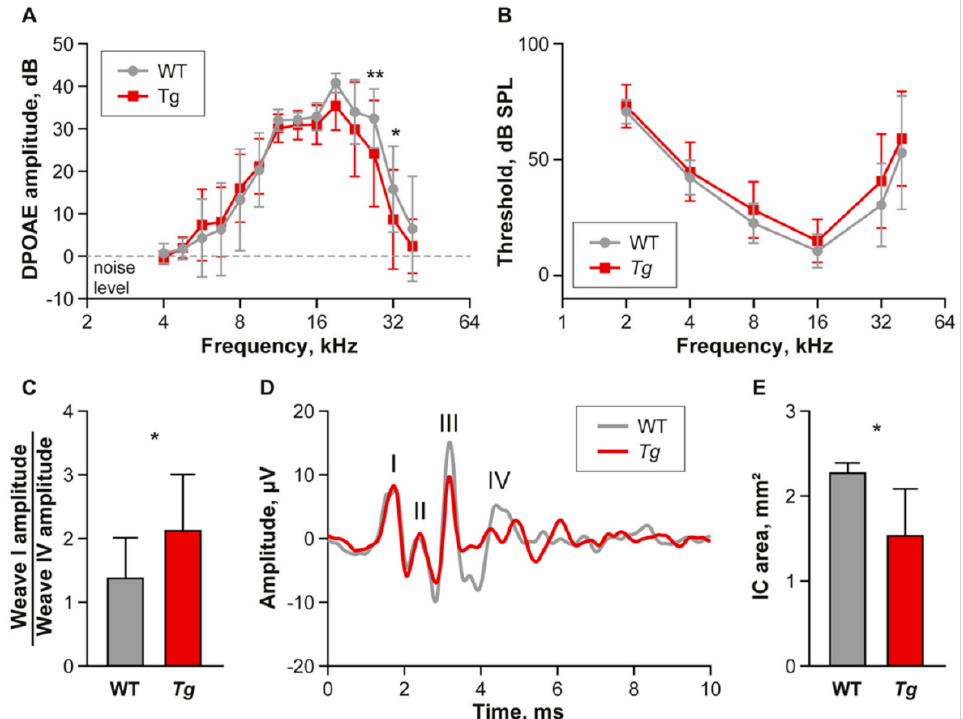
Figure 1. Hearing function of wild type and Tg animals. ( A ) Distortion product otoacoustic emissions are significantly impaired in high frequencies of Tg mice. Mean ± SD, repeated measures two-way ANOVA, Uncorrected Fisher’s LSD post-hoc test, * p < 0.05, ** p < 0.01. ( B ) ABR thresholds are not different between the groups. Mean ± SD, repeated measures two-way ANOVA. ( C ) Ratio of wave I amplitude to wave IV amplitude is increased in transgenic animals compared to wild type. Unpaired t -test, * p < 0.05. ( D ) Example of ABR curve showing impaired wave IV in